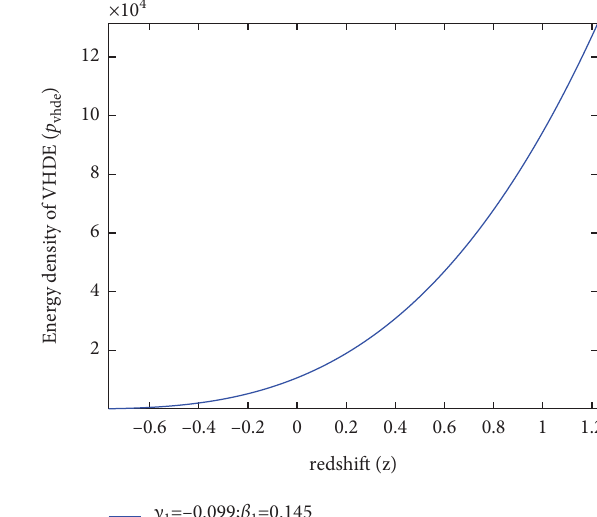
Figure 4: Energy density of VHDE ( ρ BT-II.